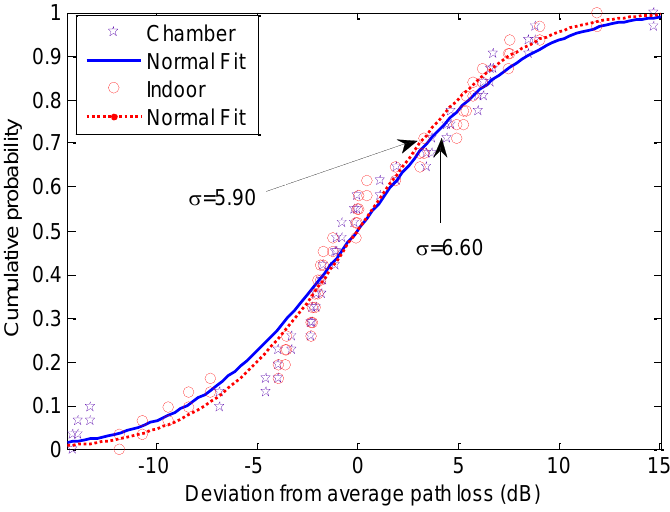
Figure 10. Deviation of measurement from the average path loss (fitted to normal distribution) for the dual band PIFA at 2.45